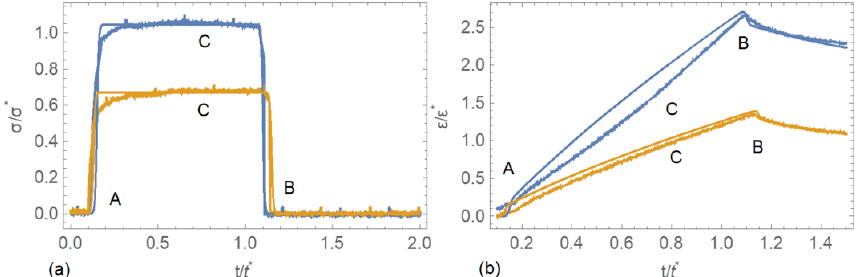
Figure B8. (a) Dimensionless stress and (b) normalized strains versus dimensionless time. Thick and thin lines correspond to measured and simulated quantities, respectively. Blue and yellow lines correspond to two LU tests with a core of columnar sea